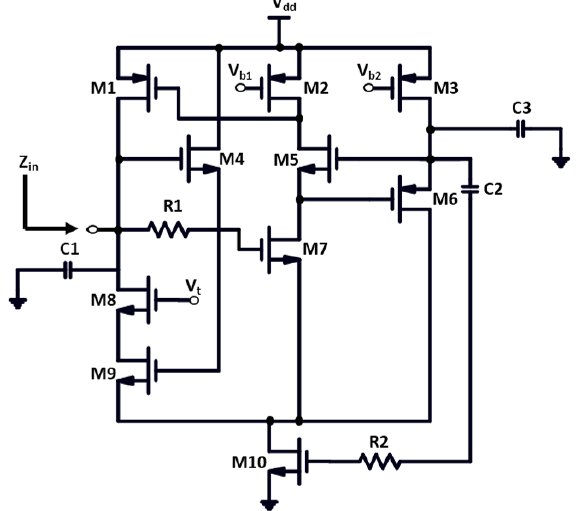
Figure 4. Proposed circuit design for an advanced tunable active